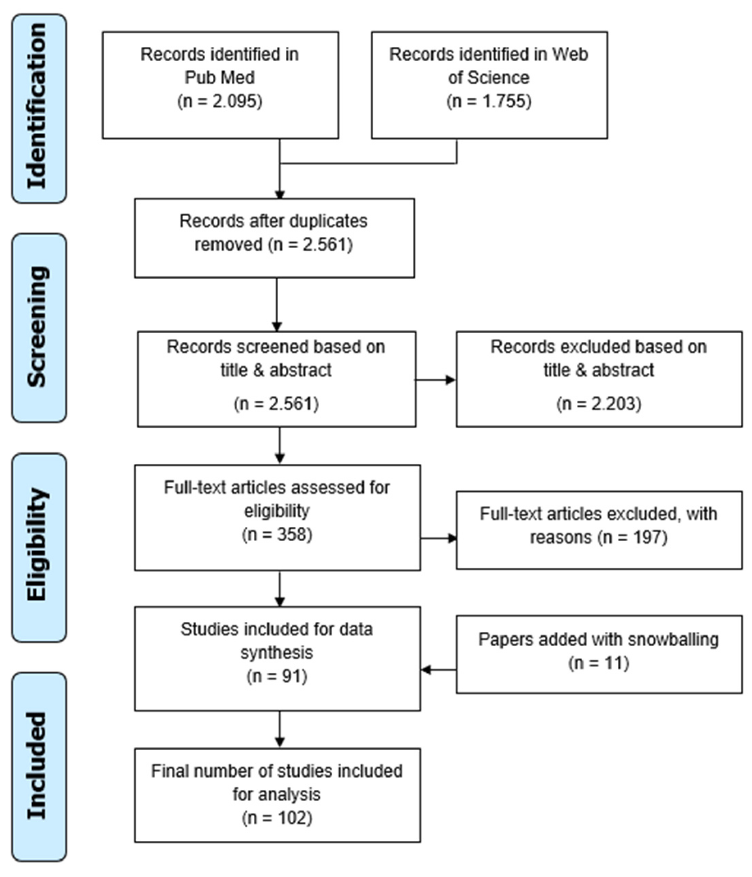
Figure 1. PRISMA Figure 1. PRISMA flowchart.